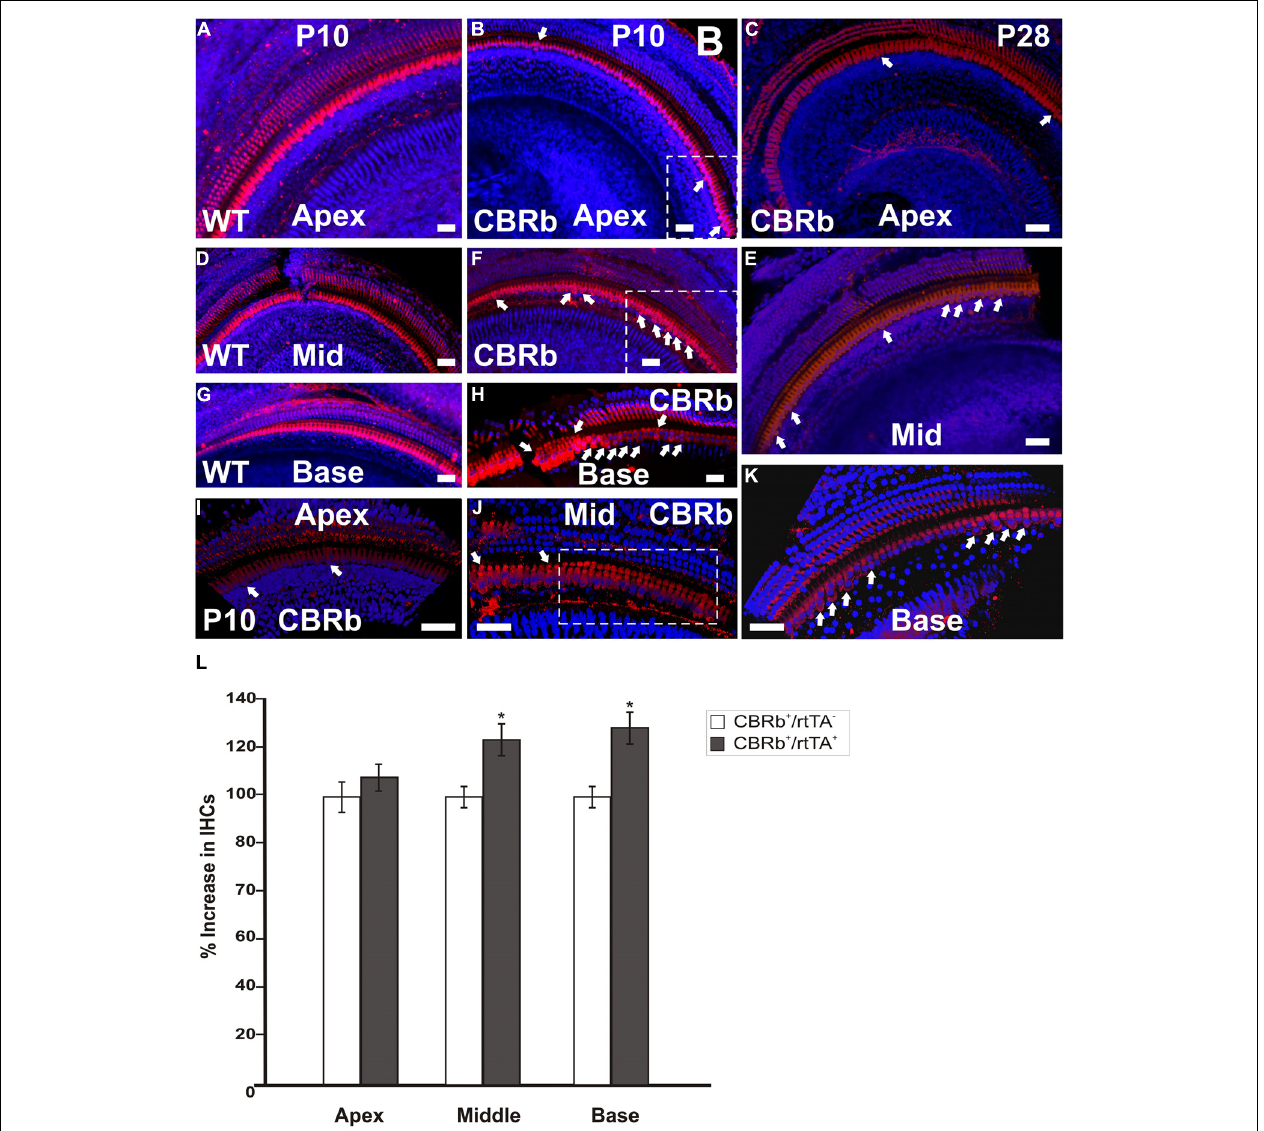
higher in P10 ears compared to P28. A close up of boxed areas in (B,E) are shown in (I) and (J) , respectively. Boxed area in (J) highlights an area where IHCs are seen in as a double row.The blue background in all figures corresponds to DAPI staining. Bar = 10 μ m. (L) Counting of Myosin VIIa-positive cells at the IHCs’ region of CBRb mice cochleae at P10 revealed a significant increase in cells, particularly at the middle and basal turns, when compared to DN-CBRb − / ROSA-CAG-rtTA + mice. Error bars show SEM. * P <